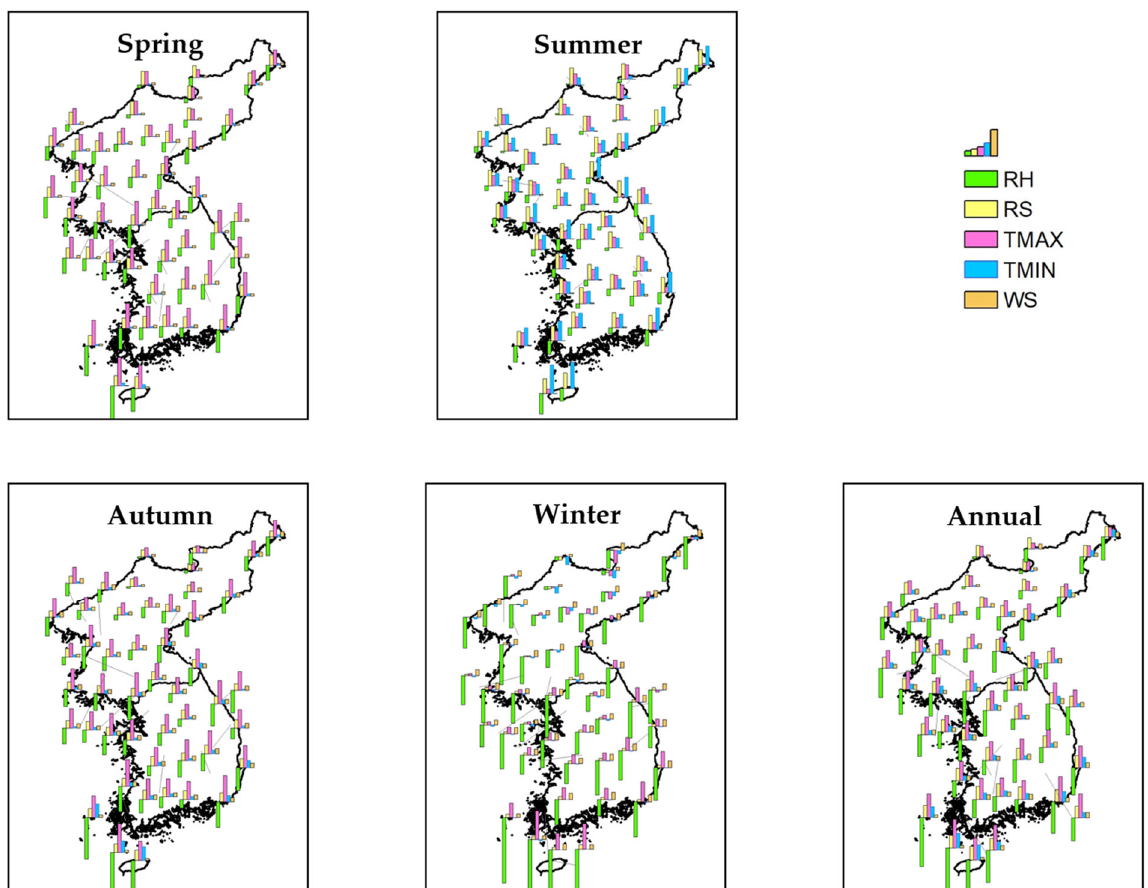
Figure 5. Spatial distribution of the sensitivity coefficients of ET o to meteorological variables over the Korean Peninsula. Table 6. The results of the sensitivity analysis on seasonal and annual scales in different geographic conditions.